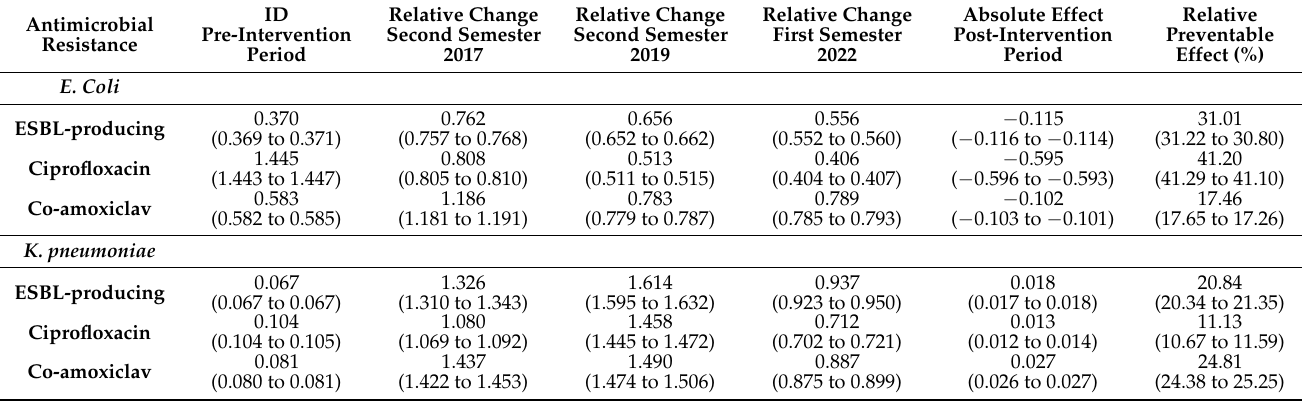
Table 3. Changes in incidence density and final impact.